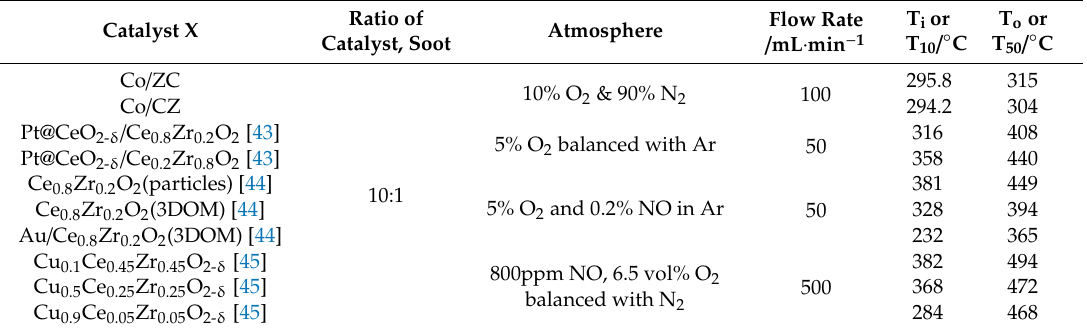
Table 4. The soot combustion parameters compared to other catalysts. Catalyst